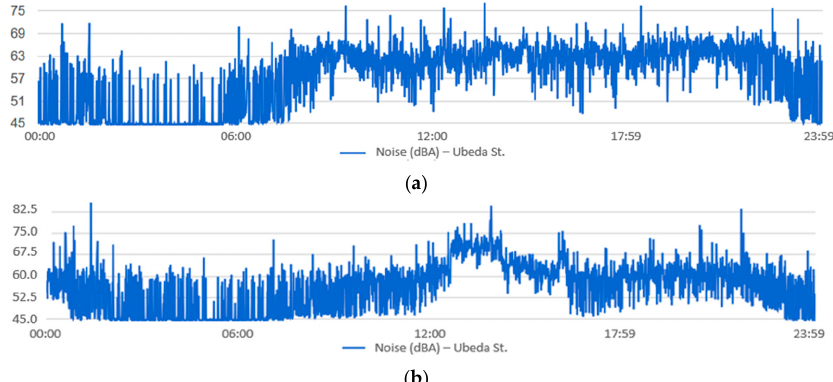
Figure A6. The temporal evolution of the noise in Ubeda Street during: ( a ) a weekday, 9 November 2016; ( b ) a weekend day, 13 November 2016.